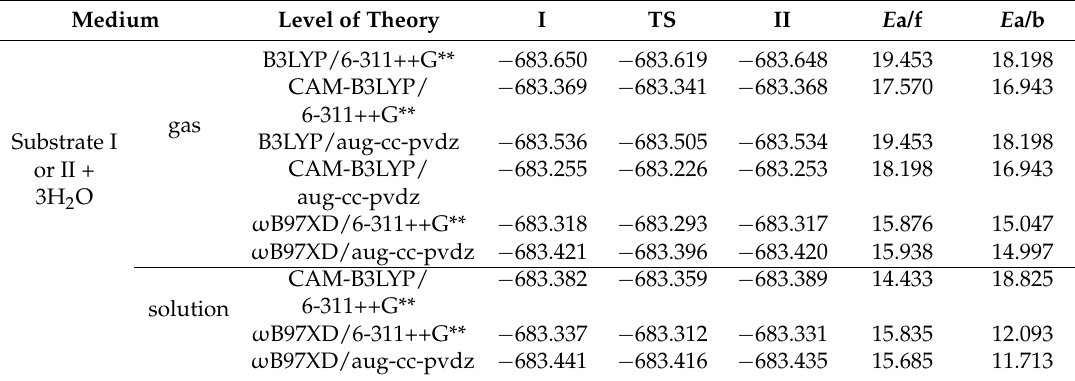
Table 6. Zero-point electronic energies (a.u.) and forward ( E a/f) and backward ( E a/b) activation energies (kcal/mol) of the gas- and solution-phase water-assisted tautomerization of imidazole-4-acetic acid (I) and imidazole-5-acetic acid (II) through the transition state (TS) using the elected levels of theory.